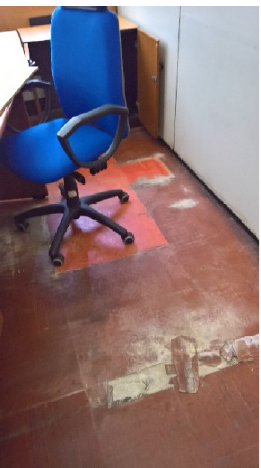
Figure 2. Example of damaged vinyl–asbestos floor tiles in office building.